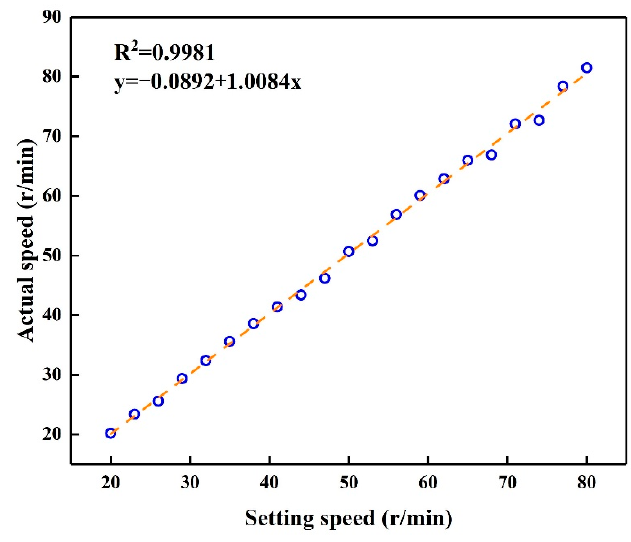
Figure 17. Electric steering wheel speed test.